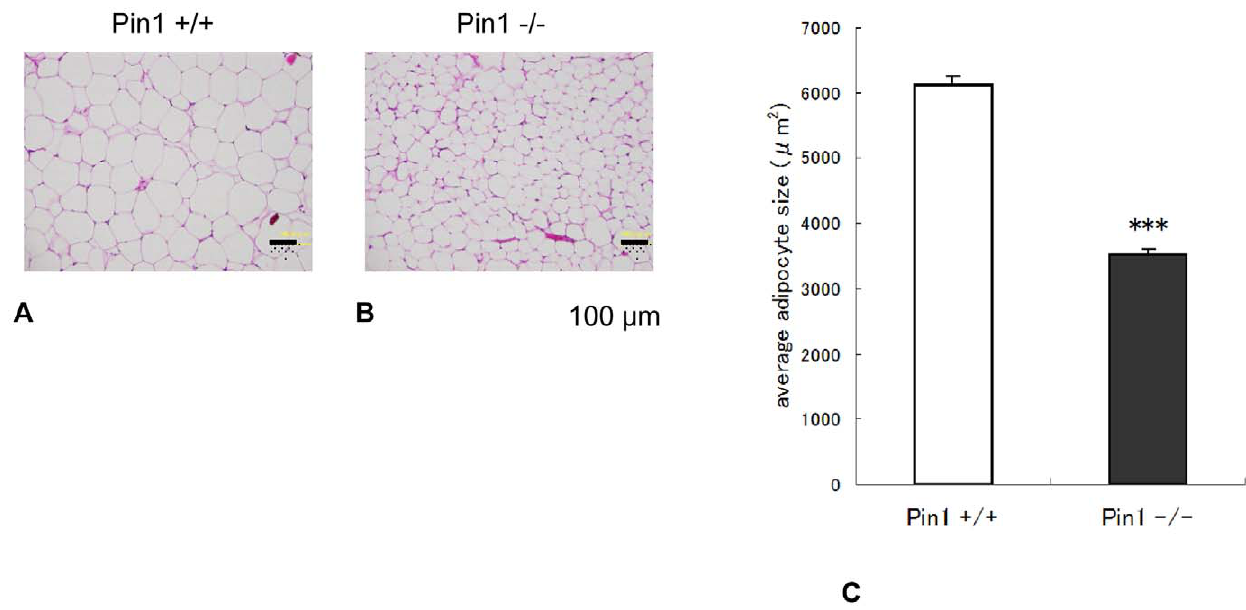
Figure 3. Pathological analysis of adipose tissues from wild-type and Pin1 2 / 2 mice. Paraffin-embedded sections of inguinal fat tissue from wild-type (A) and Pin1 2 / 2 (B) mice were stained with hematoxylin and eosin. The size of cells was analyzed quantitatively with Image J analysis soft. The average sizes of the adipose cells of wild and Pin1 2 / 2 mice were 6129.6 6 136.0 m m 2 and 3516.6 6 87.0 m m 2 ( 6 SEM) respectively (Figure 3C). Student t-test p , 0.001.